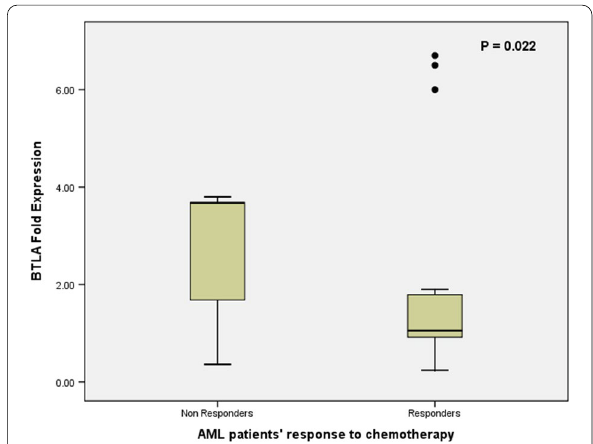
Fig. 3 BTLA fold expression with respect to AML patients’ response to chemotherapy. Box represents the interquartile range. Line inside the box represents the median. Whiskers represent minimum and maximum values. Dots represent individual observations